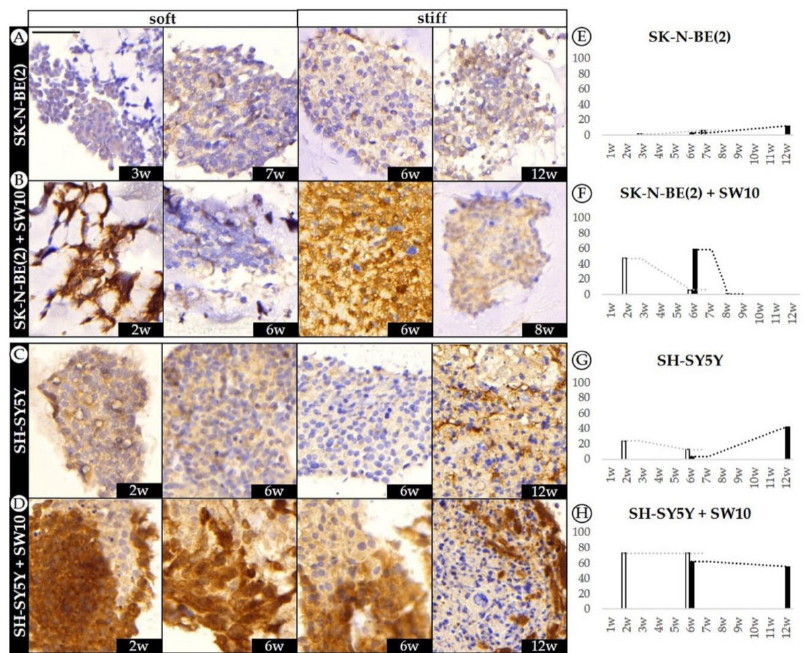
Figure 5. Dynamics of DOCK8 expression pattern in SK-N-BE(2) and SH-SY5Y over time. ( A – D ) Representative images of DOCK8 expression at the time points studied (w: weeks) in soft and sti ff sca ff oldings. Top images correspond to the SK-N-BE(2) cell line cultivated ( A ) alone and ( B ) with SW10; the images on the bottom represent the SH-SY5Y cell line cultivated (C) alone and ( D ) with SW10 cells. Scale bar 50 µ m at top left of the first image. Same scale bar is valid for all images. ( E – H ) Bar chart quantification of DOCK8 staining (% of positive cells) for SK-N-BE(2) cells ( E ) alone and ( F ) SK-N-BE(2) cells plus SW10 cells in soft and sti ff sca ff olds, and SH-SY5Y cells ( G ) alone and ( H ) S-SY5Y cells plus SW10 cells in soft and sti ff sca ff olds. White and black bars: soft and sti ff sca ff olds, respectively. Dashed lines indicate moving average per sti ff ness condition. X axis: time in weeks (w) and Y axis: % of positive DOCK8